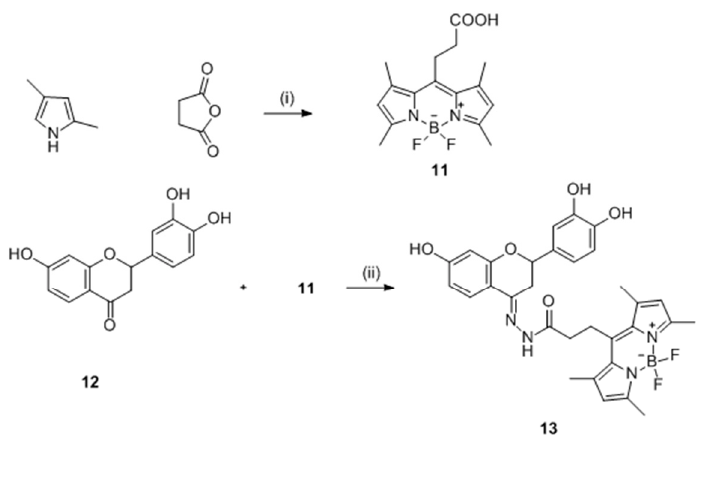
Figure 5. Model of signalling pathways involved in naringenin-induced melanogenesis [55]. Chalcones